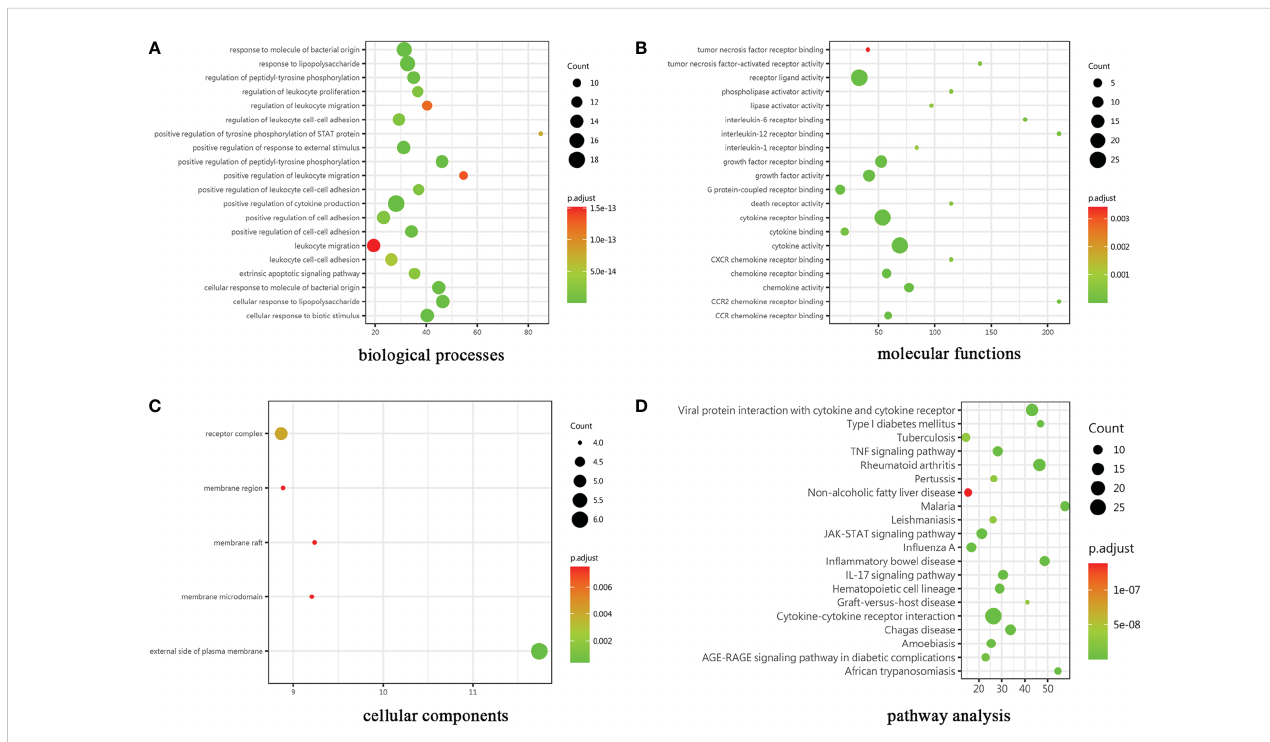
FIGURE 3 Results of GO and KEGG pathway analysis. The gene ontology categories were (A) biological processes, (B) molecular functions and (C) cellular components. (D) KEGG: Kyoto Encyclopedia of Genes and